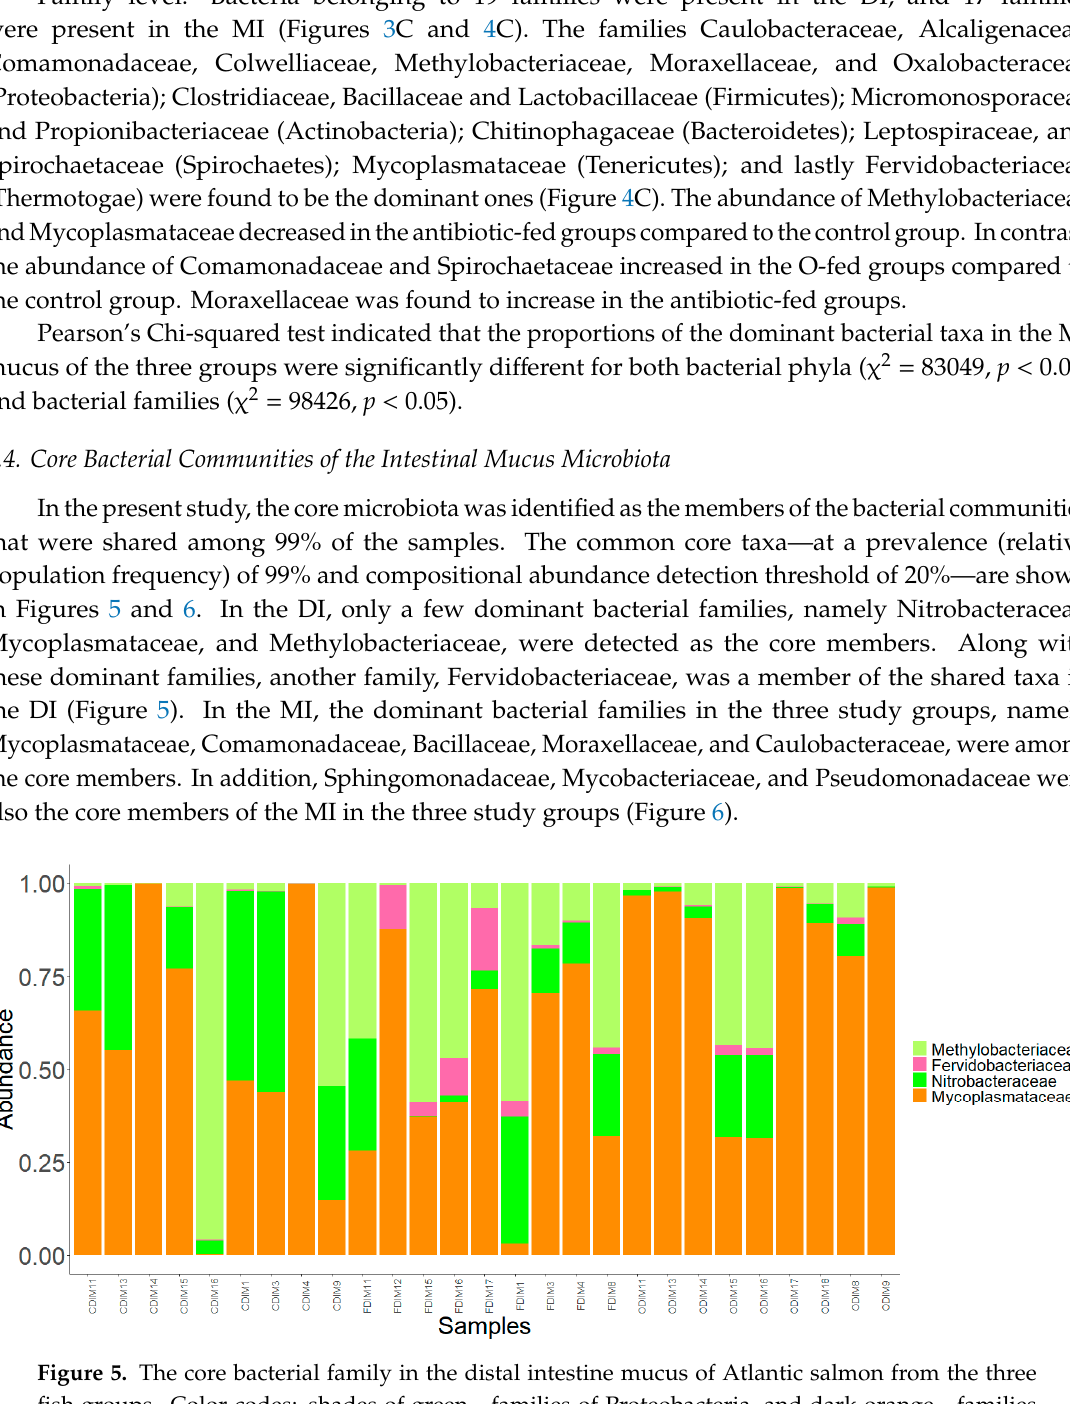
Figure 6. The core bacterial family in the mid intestine mucus of the three fish groups. Color codes: shades of green—families of Proteobacteria, yellow—families of Firmicutes, purple—families of Actinobacteria, and dark orange—families of Tenericutes. 3.5. Significantly Abundant Taxa of the Intestinal Mucus Microbiota ANCOM analysis detected seven significantly abundant OTUs (compared to those in the control fish) in the DI, which included Cytophageaceae, Burkholderiaceae, Rhizobiaceae, two OTUs belonging to Sphingomonadaceae, and two OTU’s belonging to Flavobacteriaceae. ANCOM analysis did not detect any OTU that had significantly different abundances in the MI of the three groups. 3.6. Co-Occurrence Network Description of OTUs A single-domain bacterial (SDB) network shows the co-occurrence networks to understand the possible biological interactions occurring among microbial communities. A typical SDB network consists of a set of nodes and a set of edges. The nodes indicate OTUs or phyla, and edges indicate the line connecting the two nodes. The number of connections that one node has with other nodes is the degree of a node. The number of the shortest path that passes through the nodes in the network is evaluated as betweenness. Furthermore, a selectively connected labeled pair of nodes is quantified by the assortativity coefficient.